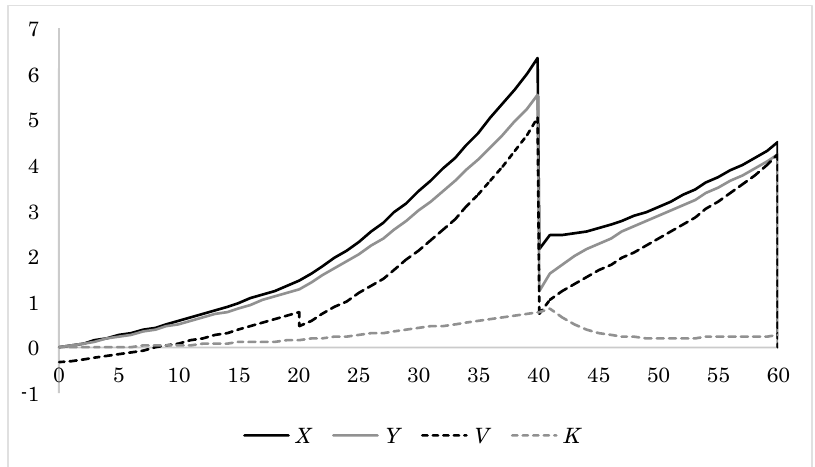
Figure 8. Approximated expected assets X , technical reserve Y , market reserve V and collective bonus potential K as a function of